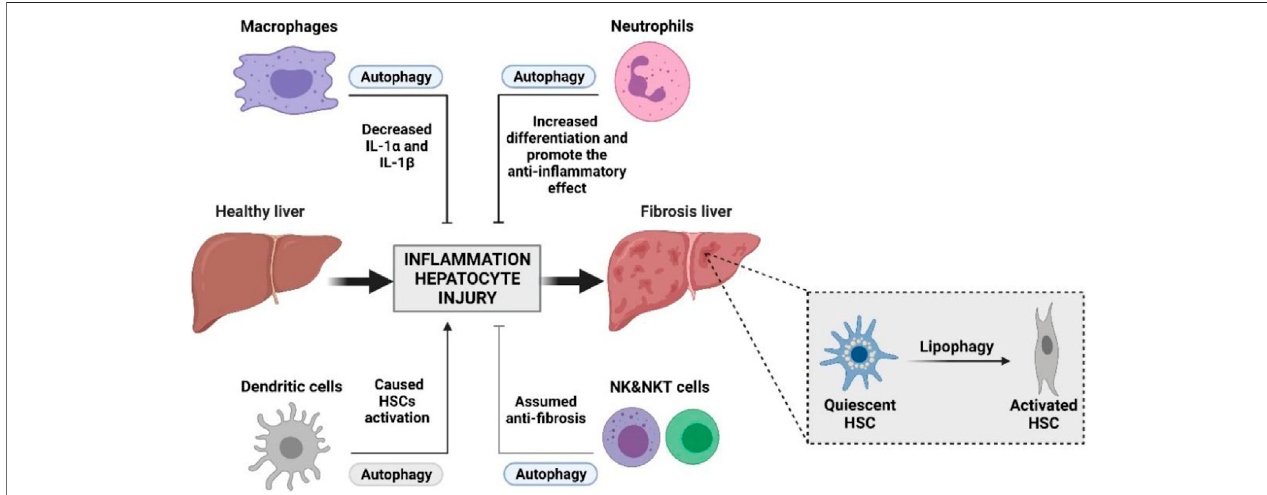
FIGURE2| Interplay betweenautophagy and innateimmunityduringliverdamagewith fi brosisprocessing. Innateimmunityplaysanimportantroleinliver fi brosis. Activation of HSCs and the remodeling of the hepatic microenvironment by accumulation of the ECM is essential to the initiation and progression of liver fi brosis. The interplay between autophagy and innate immunity may become an important part of intervention in the treatment of liver fi brosis.